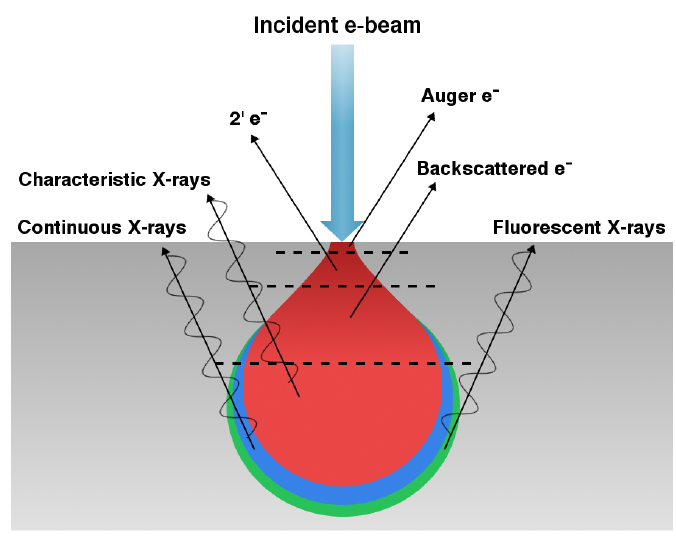
Figure 11. The interaction volume of an incident beam of electrons produces a variety of effects at different depths. SEM utilizes the secondary 2’ electrons for surface imaging, whereas EDS utilizes characteristic X-rays for elemental